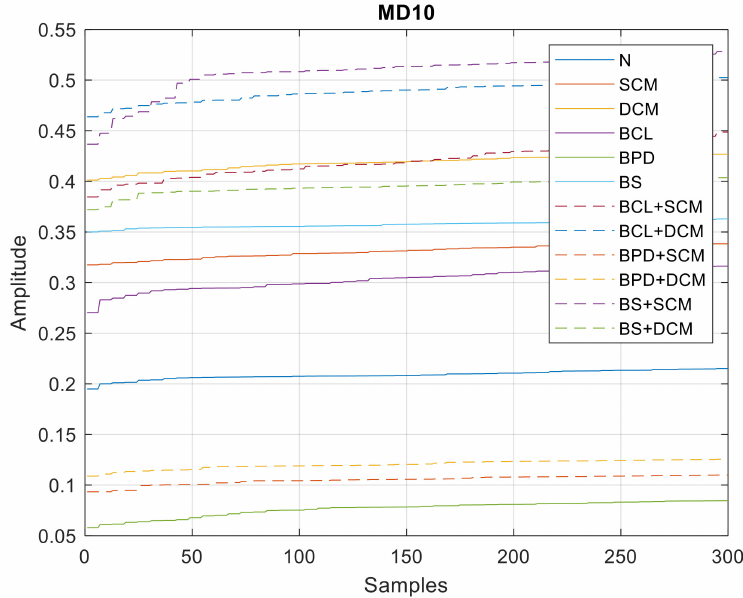
Figure 23. MD10 values—single and double/simultaneous